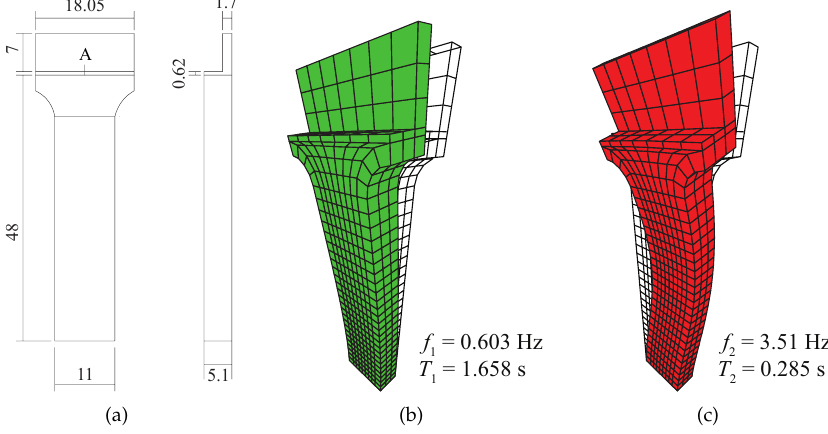
Figure 8. Equivalent pier: ( a ) geometry (dimension in m), ( b ) mode 1, and ( c ) mode